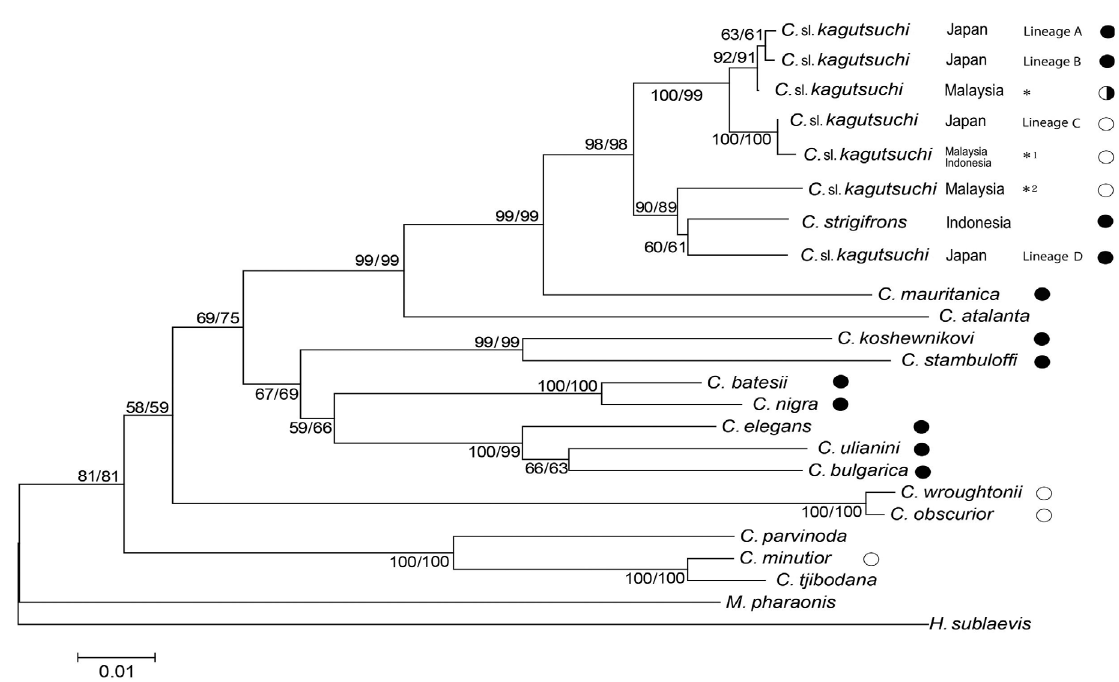
Fig 2. Neighbour-joining tree based on the mitochondrial COI/II genes (829 bp) of the ant genus Cardiocondyla and two other genera. Bootstrap support values in 5,000 pseudoreplicates for distance and likelihood analyses are shown by the left and right numbers at the node, respectively. The genera names are as follows: C — Cardiocondyla , M — Monomorium and H — Harpagoxenus . Geographic origins of C . sl. kagutsuchi and C . strigifrons are shown following their species names. Accession numbers of Lineages A, B, C and D of C. sl. kagutsuchi were AB723724, AB723726, AB723727 and AB723725, respectively. Lineage D was the same haplotype as DQ023088 (Hawaii).